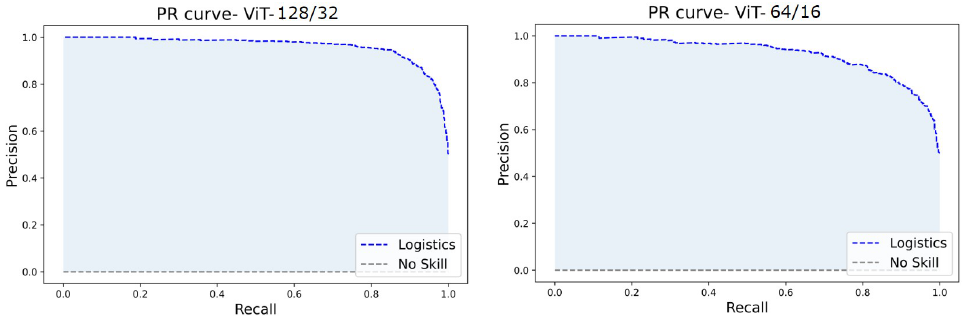
Figure 18. PR curves of ViT128/32 and ViT64/16.